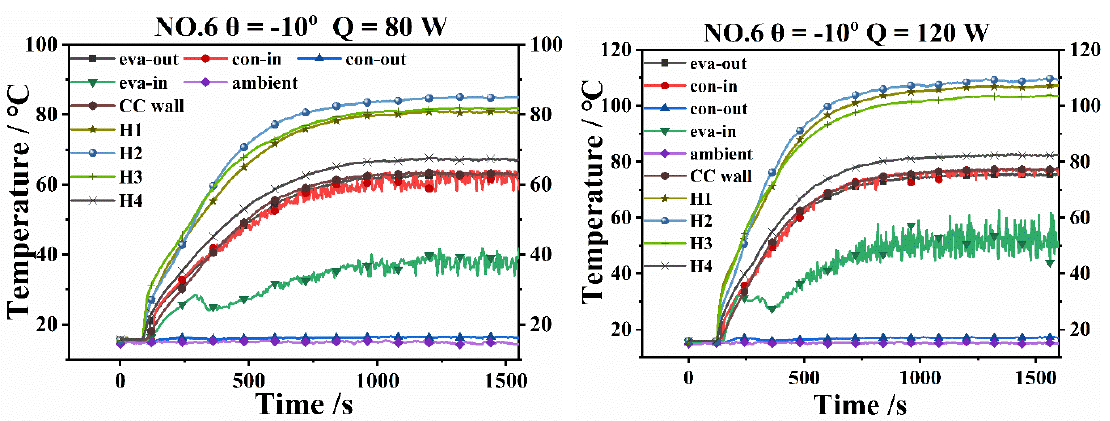
Figure 13. Temperature response during start up process of No.6 position at 80 W and 120 W.